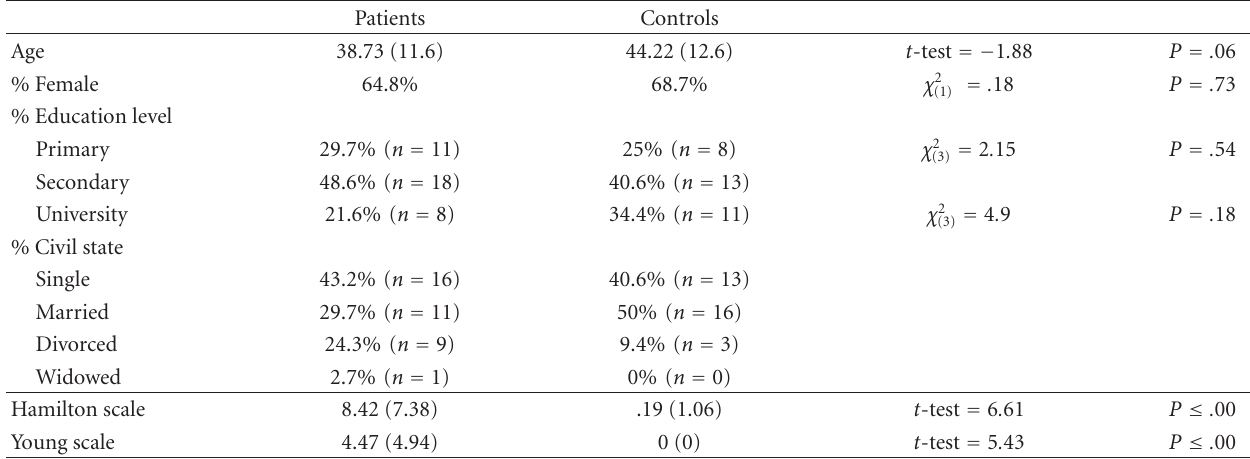
Table 1: Sociodemographic characteristics of the